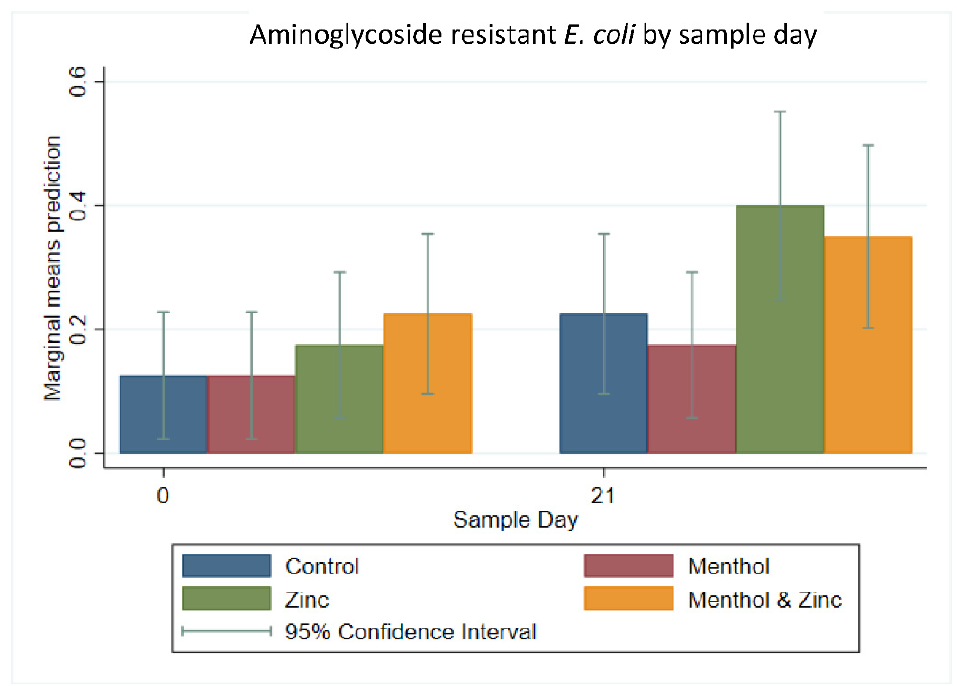
Figure 4. Marginal means with 95% confidence intervals of a 2 × 2 × 2 multi-level mixed logistic regression model, using factors of zinc, menthol and sample day on aminoglycoside-resistant E. coli.